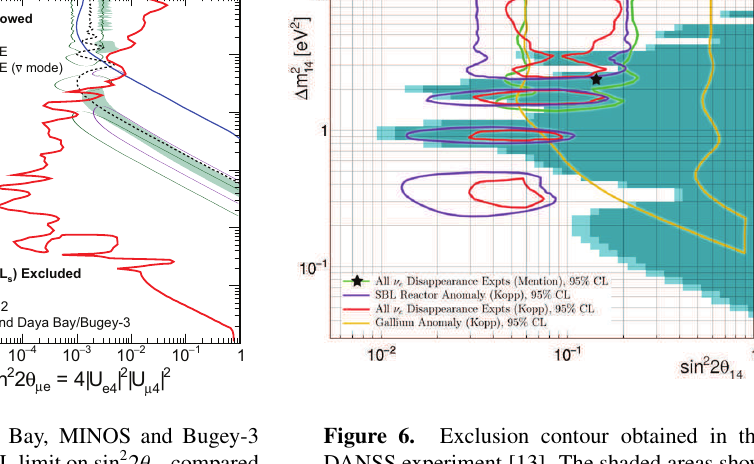
Figure 5. Daya Bay, MINOS and Bugey-3 combined 90% CL limit on sin 2 2 θ µ e compared to the LSND and MiniBooNe 90% CL allowed regions. The region to the right of the red con- tour is excluded.